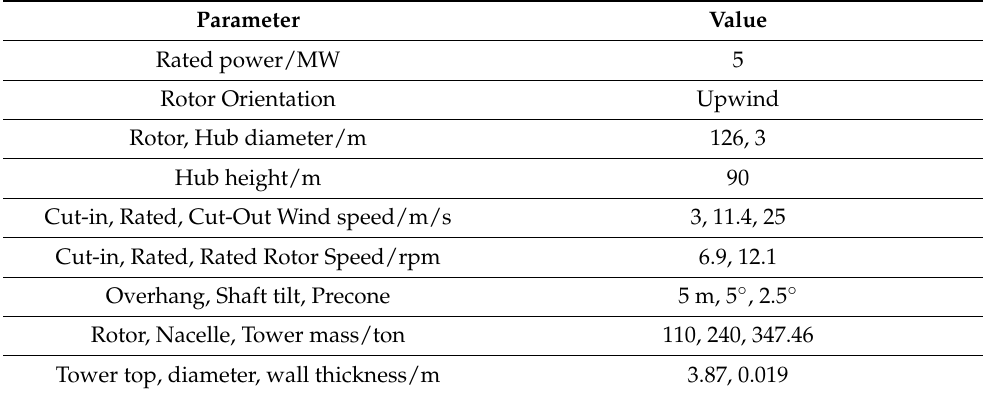
Table 1. Main properties of the NREL 5 MW reference wind turbine.